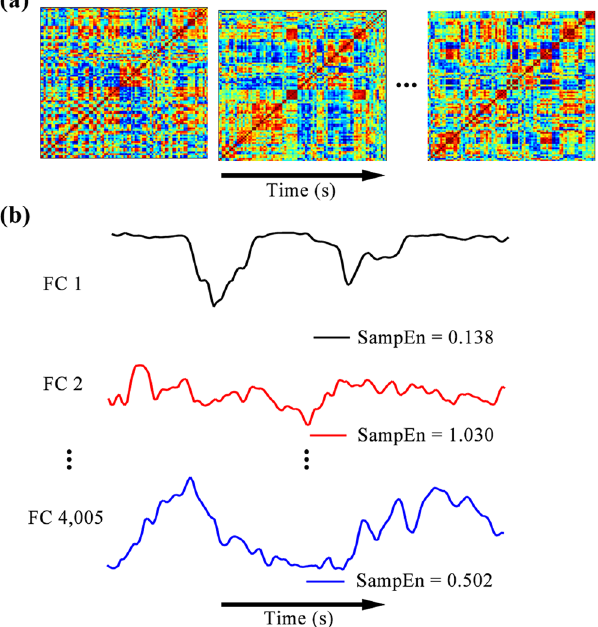
Figure 1. SampEn analysis of dynamic functional connectivity. Dynamic functional connectivity matrices at different time windows for one subject ( a ). We extracted the functional connectivity time series between each pair of ROIs from these dynamic functional connectivity matrices, and evaluated SampEn of each functional connectivity time series ( b ). FC, functional